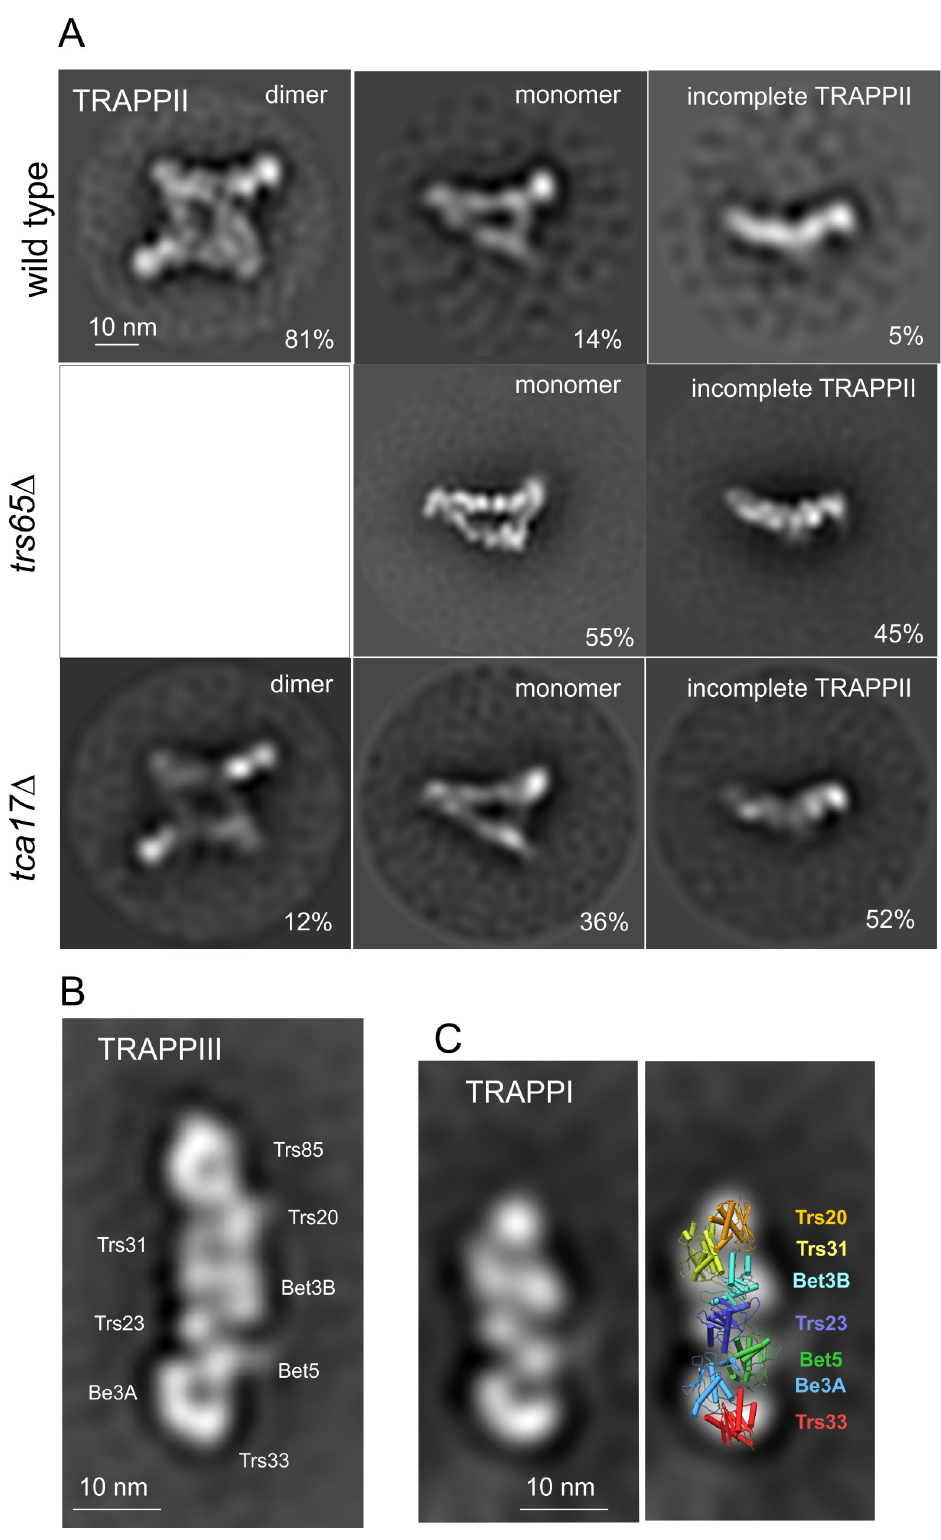
Fig 4. Negative staining 2D averages from purified TRAPP complexes. Complexes eluted from S-agarose columns were concentrated, stained with uranyl acetate and analyzed to obtain 2D class averages. (A) TRAPPII purified